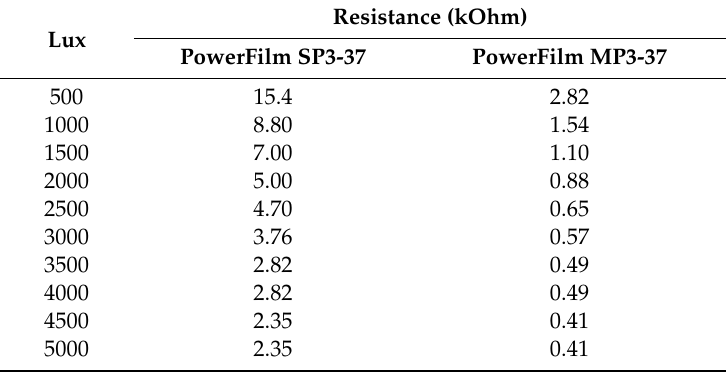
Table 3. Optimum load resistance values for solar panels.